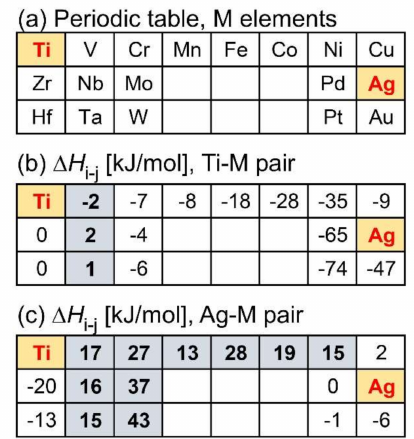
Figure 1. Periodic table and the value of ∆ H i-j in Ti–M and Ag–M atomic pairs for the alloy design of ternary Ti–Ag–M alloy with LPS. ( a ) Periodic table for considering M element in the ternary Ti–Ag–M alloy; ( b ) ∆ H i-j for the Ti–M atomic pair; ( c ) ∆ H i-j for the Ag–M atomic pair. The values of ∆ H i-j was obtained from the literature